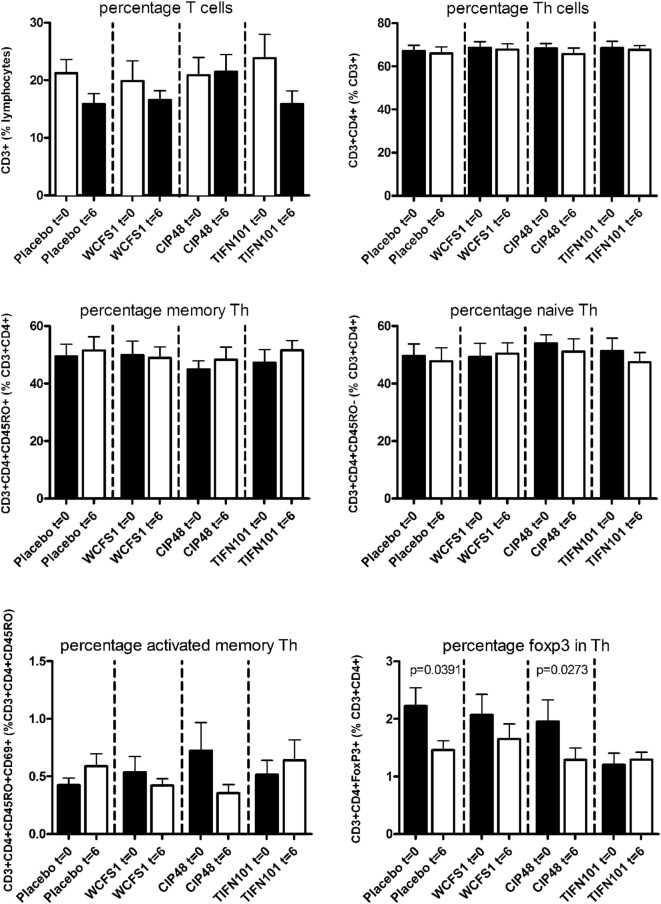
Effects of three Lactobacillus plantarum strains on the frequency of CD4+ T-cell populations in systemic circulation. Data are expressed as mean ± SEM. Statistical significant differences were determined by using two-sided Student’s t-tests. A p-value <0.05 was considered statistically significant. A p-value <0.1 was considered a statistical trend.